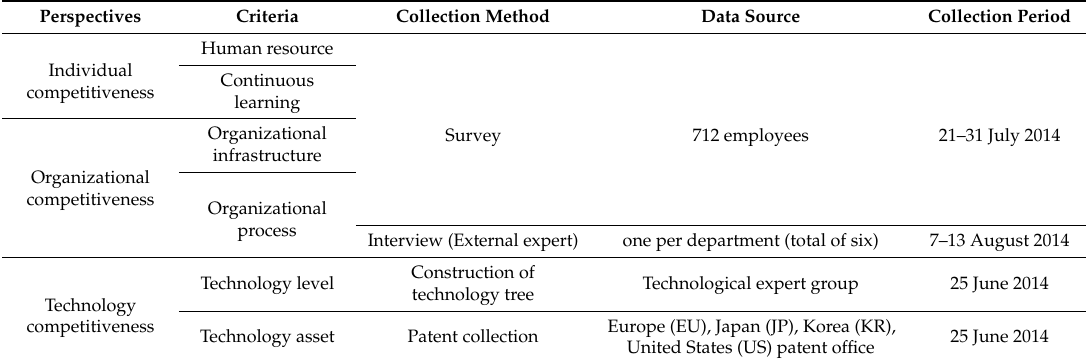
Table 5. Basic data collection for evaluating technological capabilities.